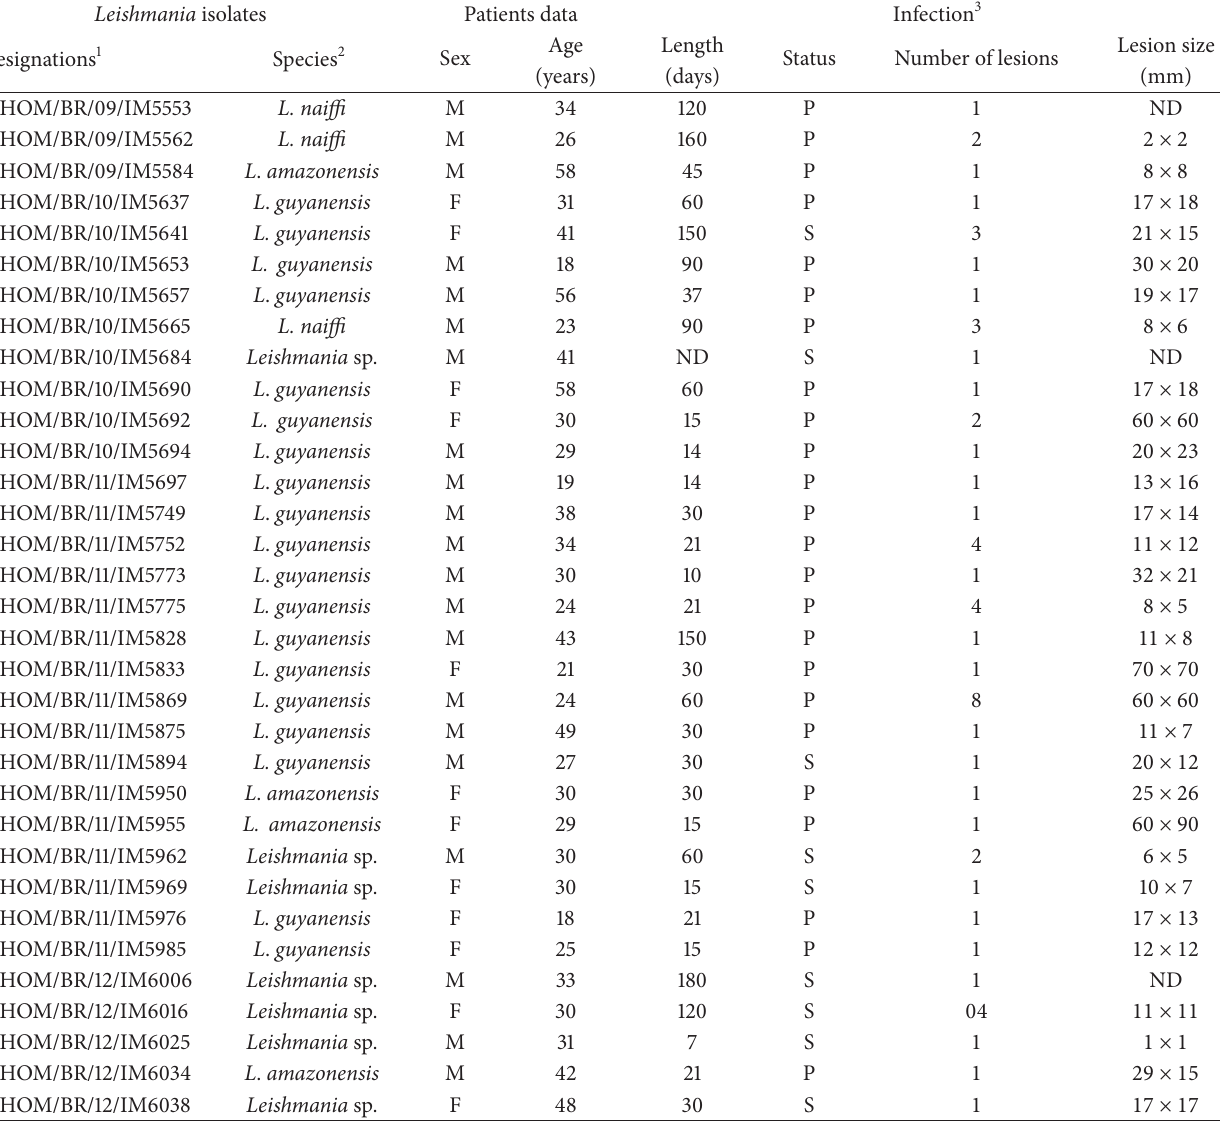
Table 1: Clinical and epidemiological data from patients ∗ infected with Leishmania spp. from Rio Preto da Eva, State of Amazonas, BR. Leishmania